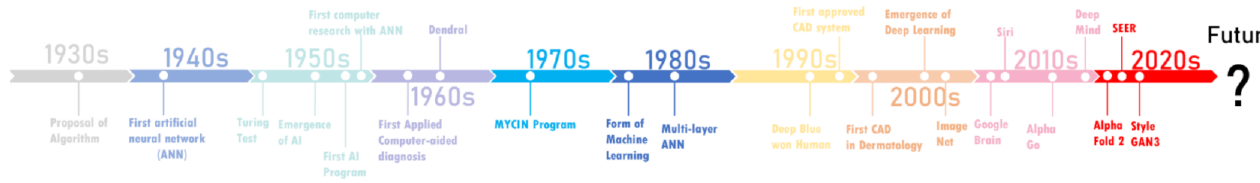
Figure 1. Flow chart illustrating the literature search and study